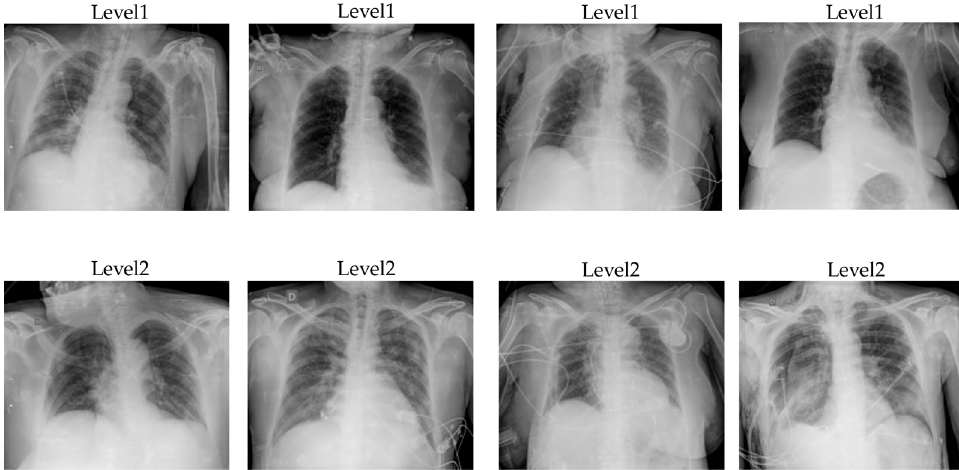
Figure 2. Image samples from the customized COVID-19 severity assessment dataset with respect to level1 and level2 classes.